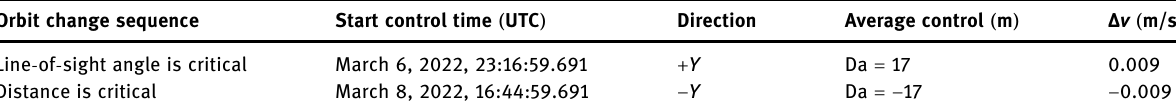
The closest distance Orbital maneuvers of the following satlite